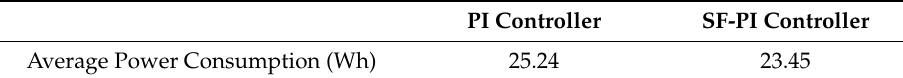
Figure 13. Voltage, Current, and Power of SF-PI controller. ( a ) Voltage and Current. ( b ) Power. Table 7. Comparison of average power consumption.